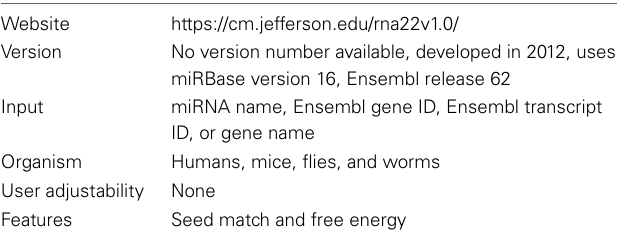
Table 5 | Profile of MirTarget2. Table 6 | Profile of rna22-GUI.